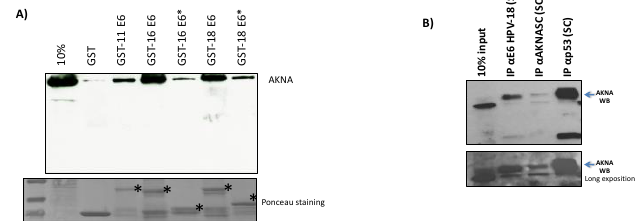
Figure 4. HPV E6 oncoproteins interact with the AT-hook factor AKNA. ( A ) Purified GST-E6 fusion proteins were incubated for 4 h with a HaCaT cell lysate to allow complex formation. After incubation, GST beads were washed using 0.1% NP-40/PBS solution to wash away unspecific binding. Bound protein was analyzed by western blot using AKNA anti-serum. GST alone was incubated as a binding control. AKNA protein is detected when incubated with GST-E6 proteins. GST-E6 fusion proteins are indicated by the asterisk ( * ). ( B ) Anti-E6 (1:25) directed against HPV18 (Santa Cruz Biotechnologies) was used to immunoprecipitate endogenous E6 in HeLa cells, after CBZ treatment to ensure high levels of protein. Anti-AKNA (1:50, Santa Cruz Biotechnologies) and anti-p53 DOI (1:100, Santa Cruz Biotechnologies) and anti-E6 (HPV18) antibodies were incubated overnight with a HeLa cell lysate obtained using RIPA buffer, after that time IgG beads were added to the cell lysate and incubated for 2 h. After several washes bound protein was ascertained by western blot using AKNA anti-serum. Western blot analysis revealed that AKNA is able to complex with E6. p53 was used as an immunoprecipitation control. Longer exposure (lower panel) is showed to demonstrate the presence of AKNA in the input. Note the appearance of AKNA bands detected when p53, AKNA and E6 are immunoprecipitated indicating the in vivo interaction between the analyzed proteins.